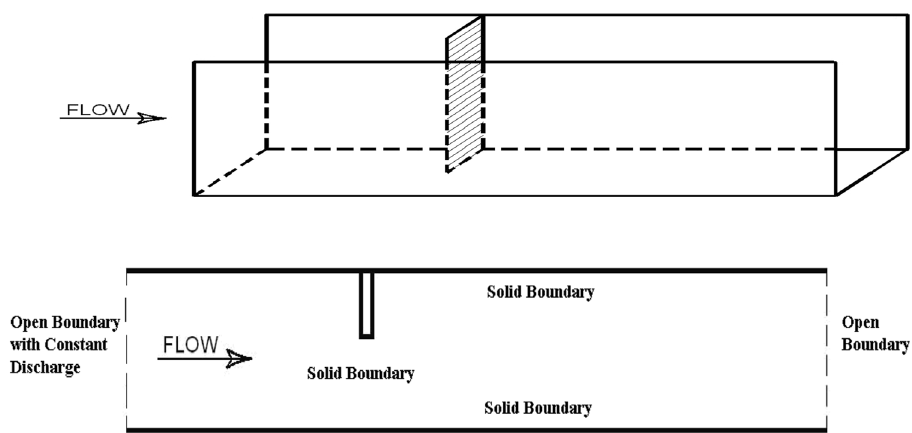
Fig. 1 The 3D view of a flume with cross-barrier